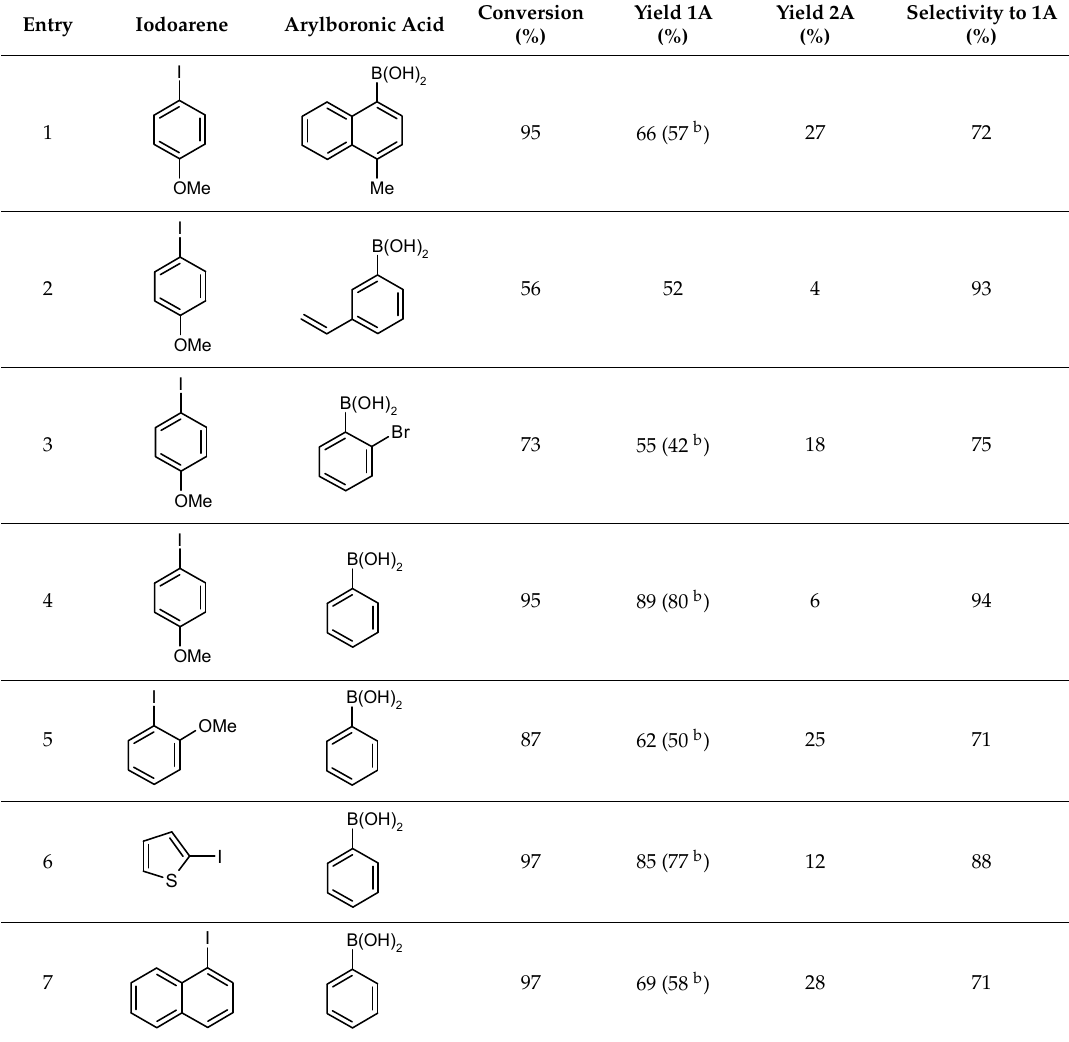
Figure 5. The carbonylative Suzuki-Miyaura reaction. Table 3. Substrate screening using Pd/GO-TiO 2 a .